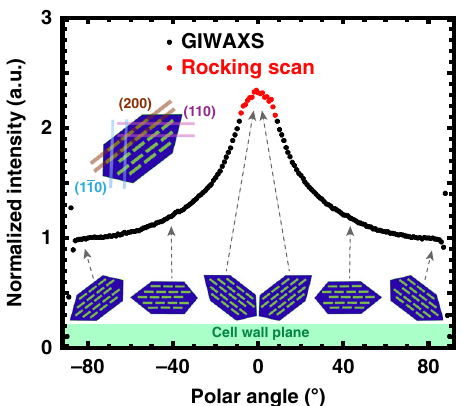
Fig. 4 χ - pole fi gure constructed from a combination of GIWAXS and a rocking scan. GIWAXS (black) and rocking scan (red) data are combined to generate a χ -pole fi gure at the cellulose (110)/(1 (cid:1) 10) re fl ection from the unextracted onion epidermal cell wall. Schematic shows the orientation of cellulose crystallites relative to the cell wall plane as implied by the pole fi gure from onion epidermis. Inset: cross-section of cellulose micro fi bril highlighting relevant crystal